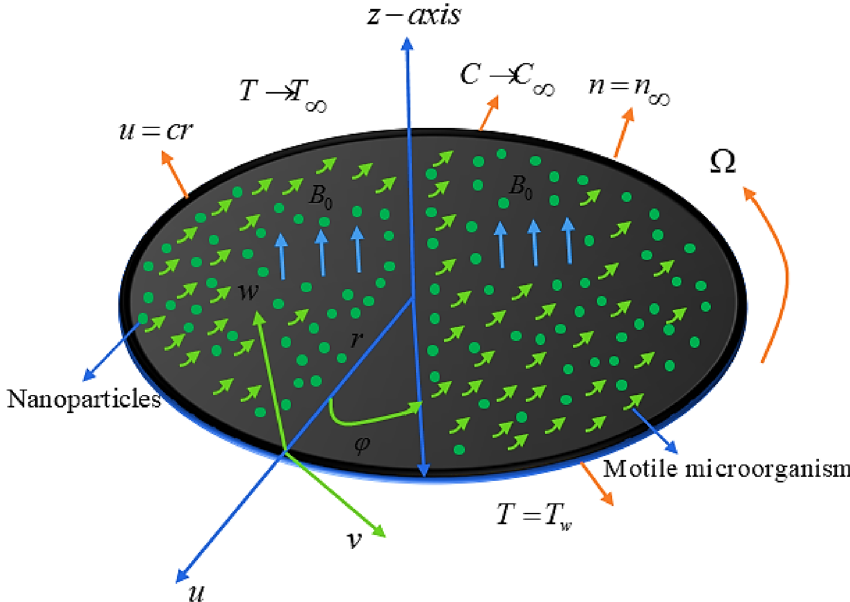
Figure 1. Physical view of